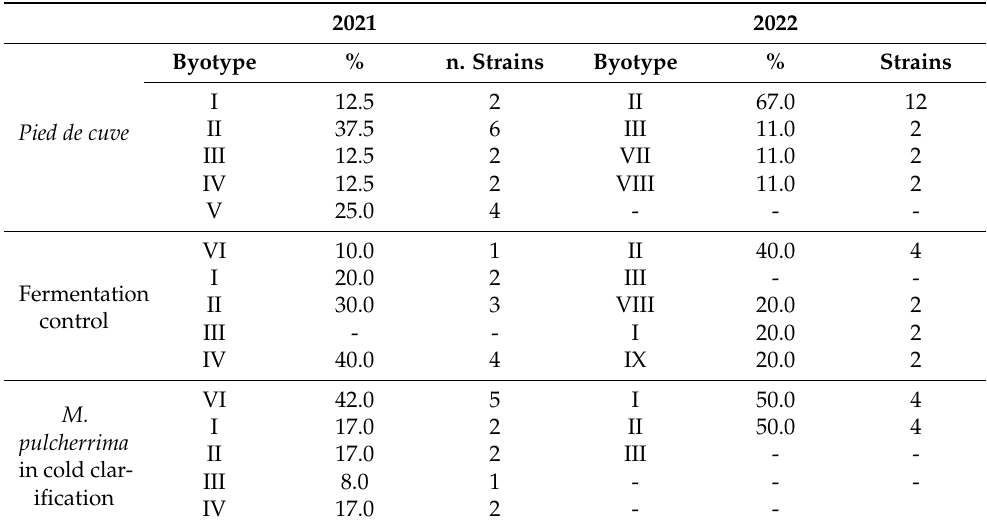
Table 1. S. cerevisiae biotypes found in the spontaneous fermentation of pied de cuves and in the fermentation